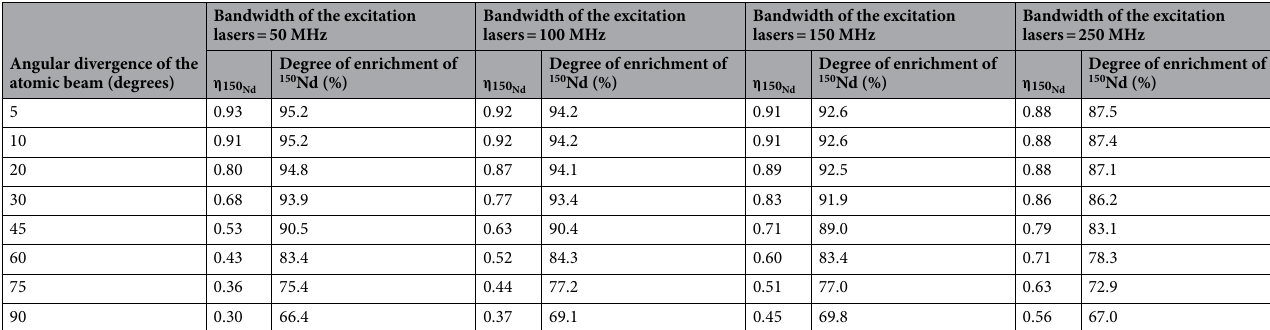
Table 3. A table of the degree of enrichment of 150 Nd for various values of angular divergence of the atomic beam and for different bandwidths of the excitation lasers. Peak power densities of the first, second and third excitation lasers are 20, 20, 78,000 W/cm 2